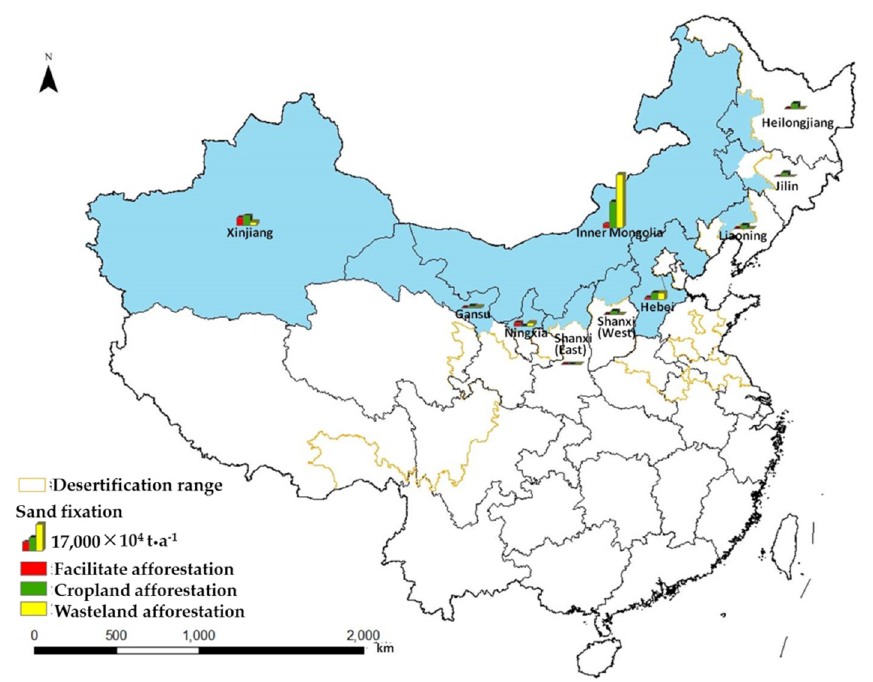
Figure 3. Sand fixation by different restoration methods.